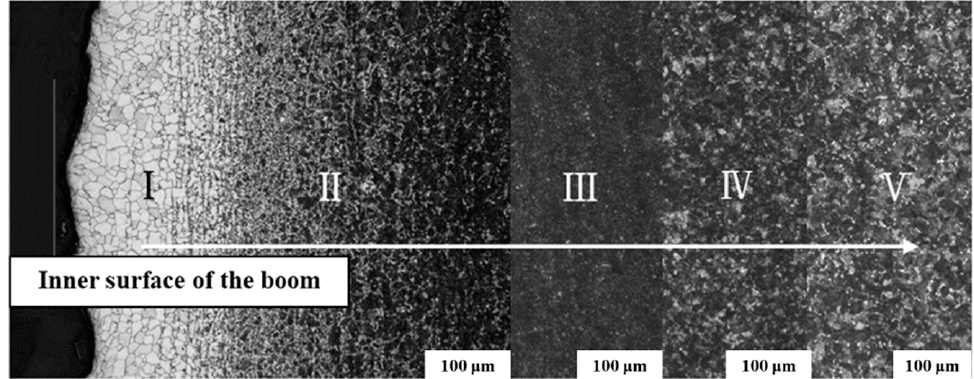
Figure 8. Microstructure of the boom near the fatigue source from the inner surface of the boom to the core.